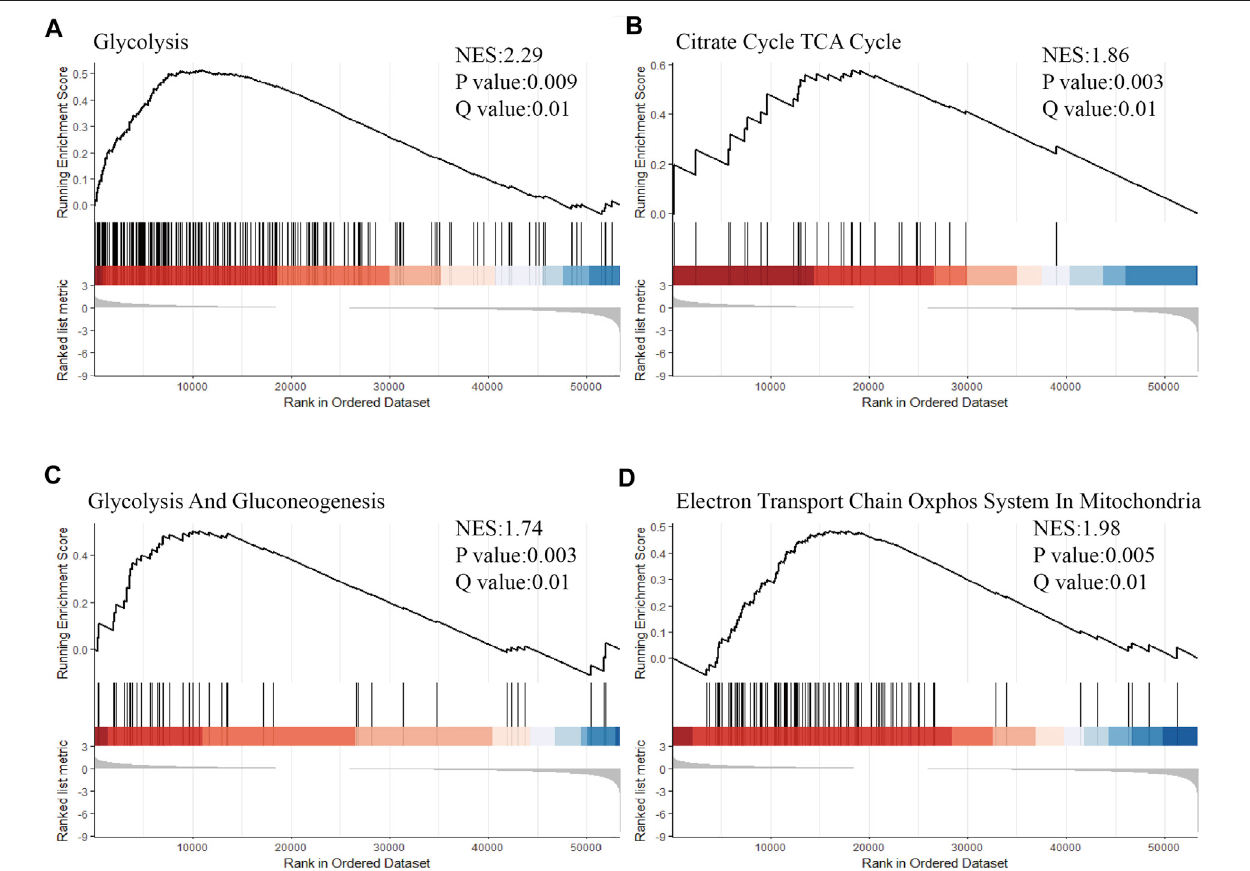
FIGURE 5 | Glucose metabolic reprogramming was suggested as one of the underlying mechanisms for immune related subgroup clustering of LUAD. Based on the immune related subgroup clustering (subgroup 1 vs subgroup 3), GSEA was performed by using the gene sets signi fi cantly associated with glucose metabolism, includingprocessesof (A) glycolysis(NormalizedEnrichmentScore(NES) (cid:1) 2.29, p < 0.01,Q < 0.05), (B) tricarboxylicacid(TCA) cycle(NES (cid:1) 1.86, p < 0.01,Q < 0.05), (C) gluconeogenesis (NES (cid:1) 1.74, p < 0.01, Q < 0.05) and (D) oxidativephosphorylation (OXPHOS) in mitochondria(NES (cid:1) 1.98, p < 0.01, Q < 0.05) (NES (cid:1) 1.98, p < 0.01, Q < 0.05). FDR < 0.05 was set as the screening threshold. An upward parabola indicated that the indicated process was enhanced in subgroup 1 in contrast with subgroup 3. The barcode plot indicates the position of the genes in each gene set; red and blue colors represent positive and negative Pearson ’ s correlation with subgroup classi fi